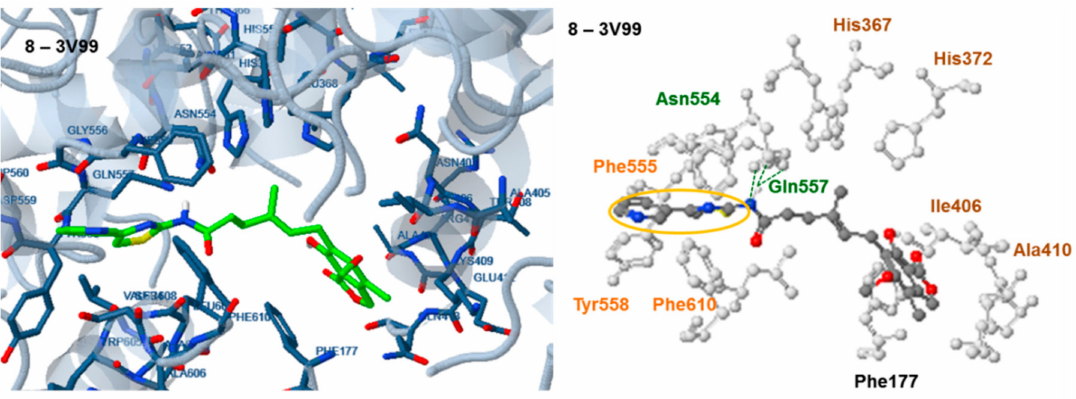
Figure 8. Docking analysis of compound, 8 , with the active site of the human 5-LOX structure PDB ID: 3V99 (target box 30). Green: hydrogen bond interactions, yellow: pi interactions, brown: hydrophobic